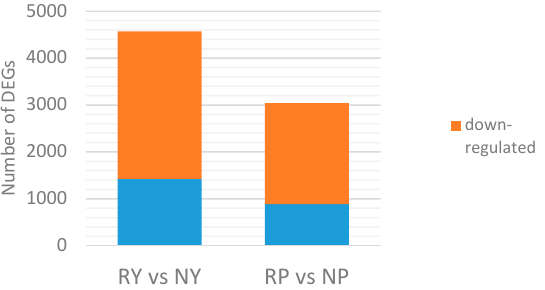
Figure 1. Unigenes differentially expressed between two different cultivars at fruit ripening stage. Blue: up-regulated genes; orange: down-regulated genes.